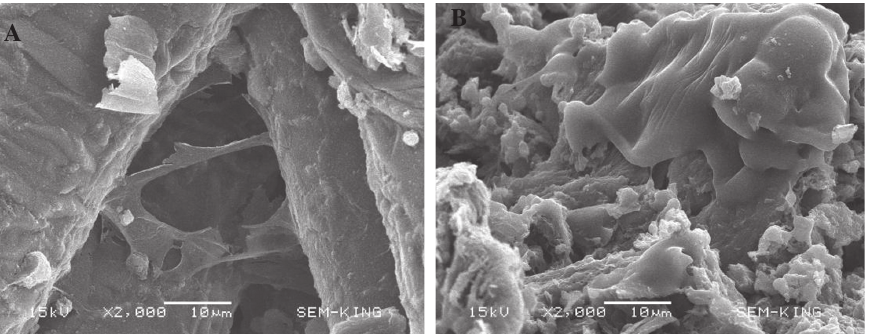
Figure 7 Scanning electron micrograph of the surface of the HA coating 150 days after implantation and the interface of HA coating: (A) C/C composite material and (B) HA coating.